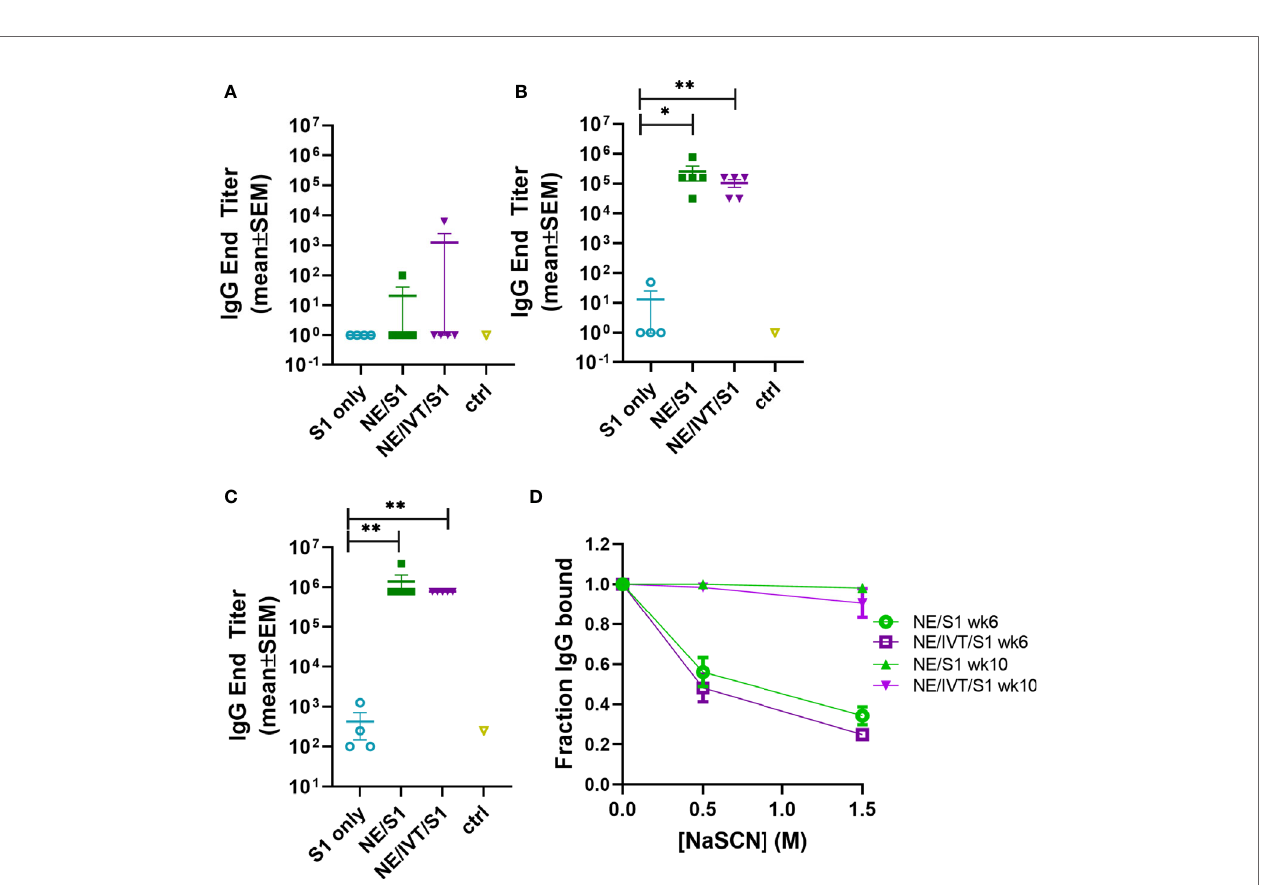
FIGURE 2 | Serum S1-speci fi c IgG titers induced by immunization with NE and NE/IVT and comparison of antibody avidity. Serum S1-speci fi c IgG measured in mice immunized IN with 15 m g S1 alone, or with 20% NE/0.5 m g IVT DI. S1-speci fi c IgG was measured 2 weeks after each immunization at (A) 2 wks post-initial immunization (prime), (B) 6 wks post-initial immunization (prime/boost), and (C) 10 wks post-initial immunization (prime/boost/boost). (*p < 0.05, **p < 0.01 by Mann- Whitney U test). (D) Antibody avidity for S1-speci fi c IgG measured by NaSCN elution for a 1:1,250 dilution of serum for the 6 wk and 10 wk sera. The control group (ctrl) consisted of untreated mice shown as mean ± SEM